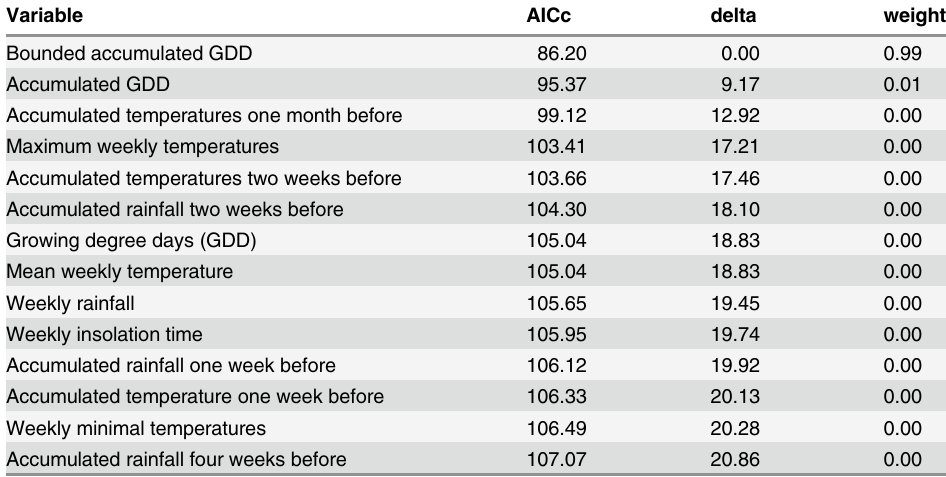
Table 1. Results of the model selection of the Generalized Linear Model with negative binomial distri- bution showing the effect of climatic variables on Ae . albopictus abundances before the inundation in 2014.